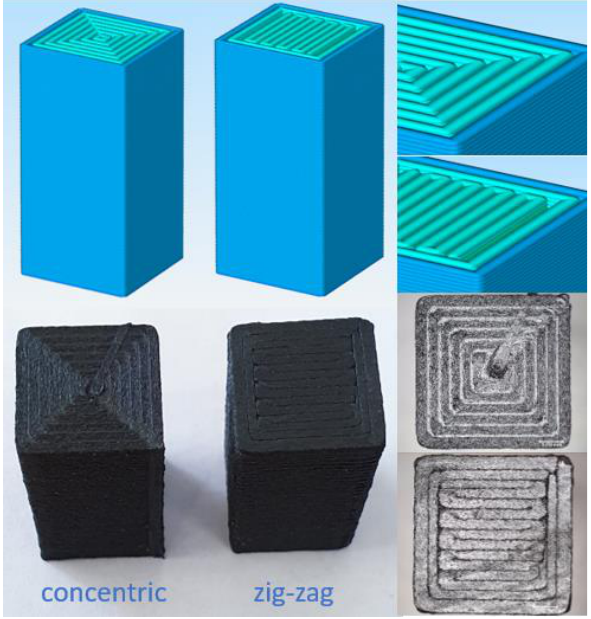
Figure 2. Sliced and real images showing print patterns of compression test specimens. Table 3. Nomenclature showing filament material, raster orientation, and frame info.